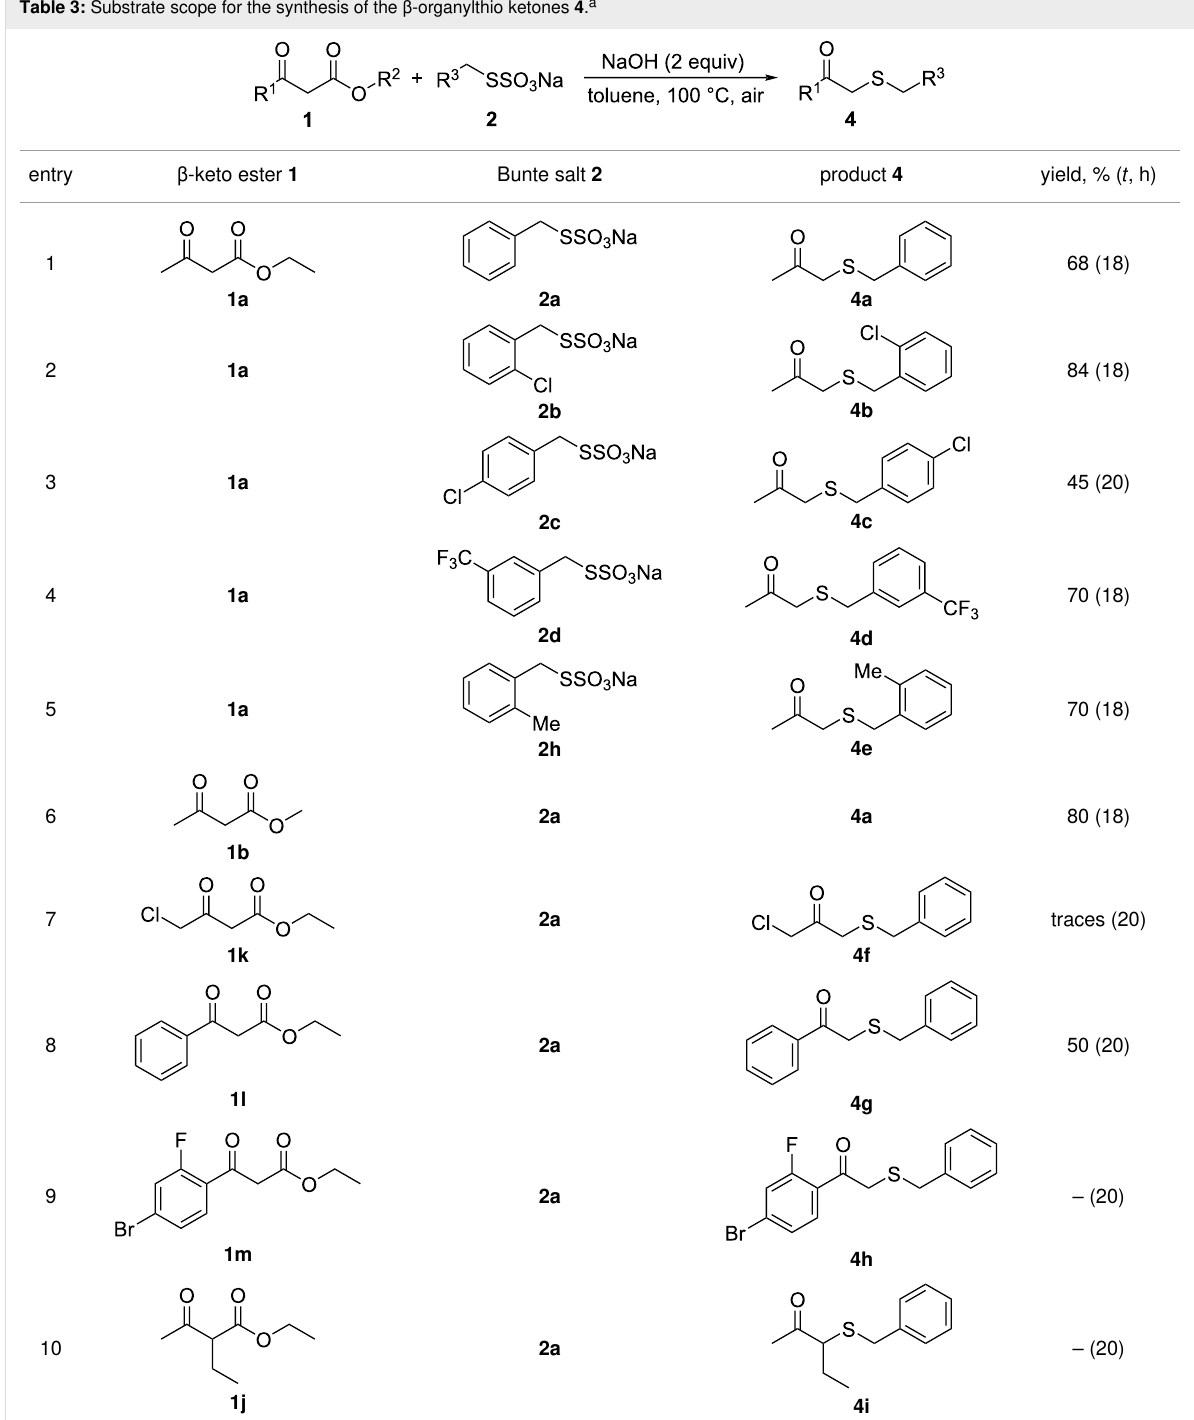
Table 3: Substrate scope for the synthesis of the β -organylthio ketones 4 .